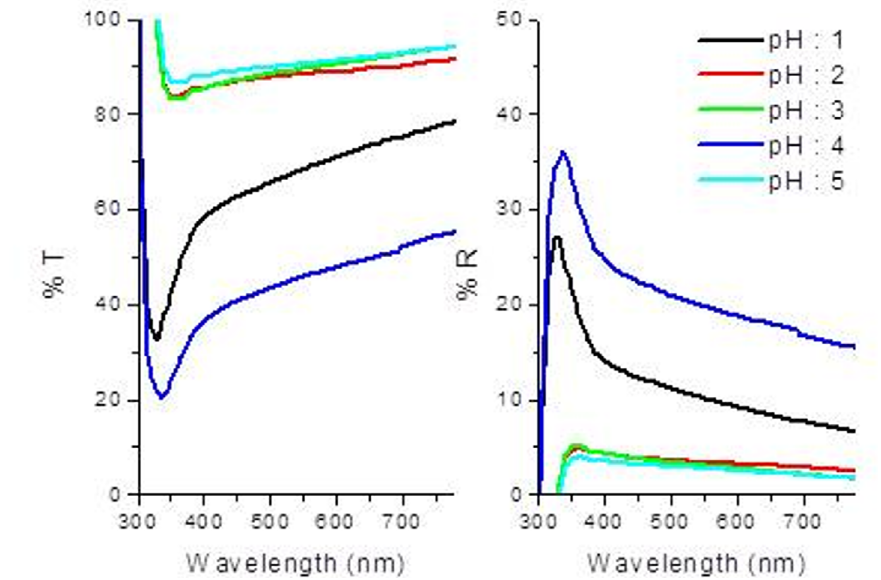
thin films produced at different pH. x